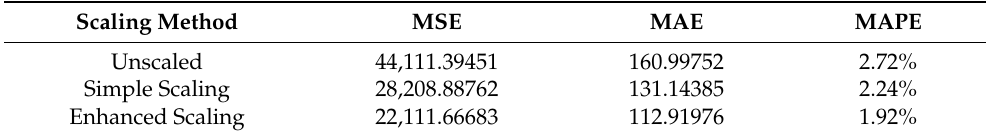
Figure 4. Graphic comparison of actual and predicted hourly load values for the year 2017. The values predicted through the proposed scaling method are added. Table 3. MSE, MAE and MAPE values for the hourly load forecast. Input data is subjected to enhanced scaling